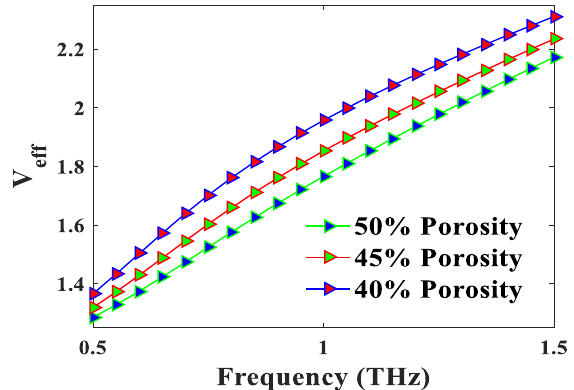
Figure 7. The V ef f as a function of frequency for different porosities.